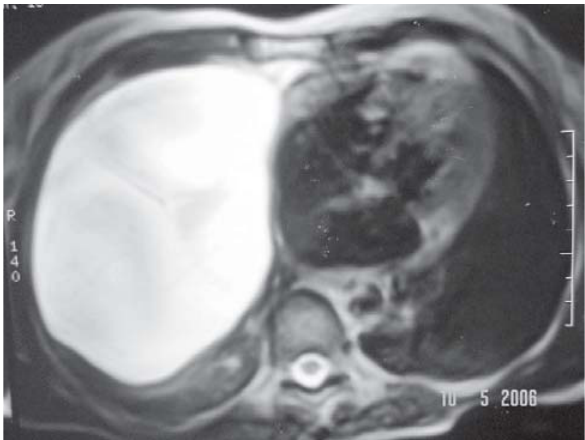
Fig. 1 - Ressonância nuclear magnética: grande estrutura cística de paredes finas contígua à borda cardíaca direita